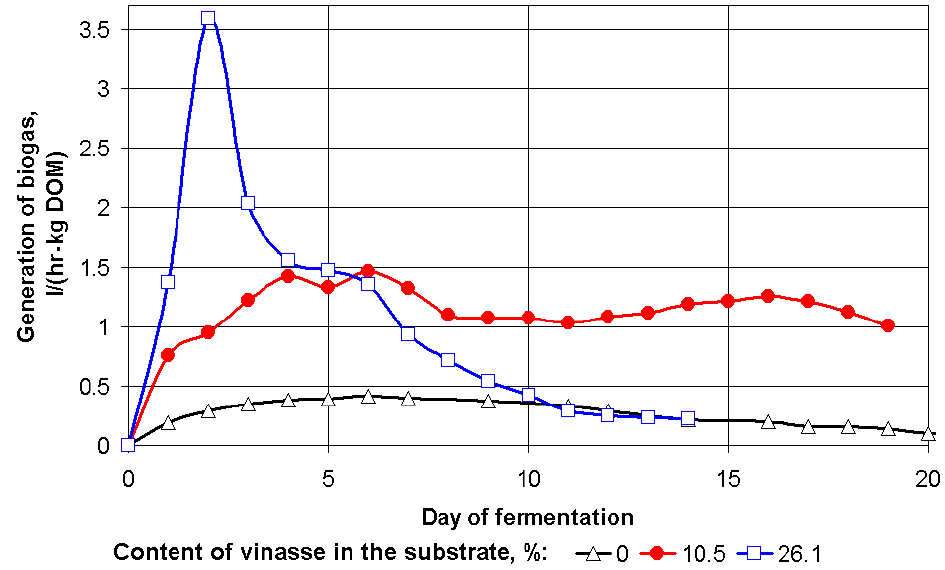
Figure 4. The output of biogas at the combined fermentation of cattle manure and molasses at a fermentation temperature of 40 °C.